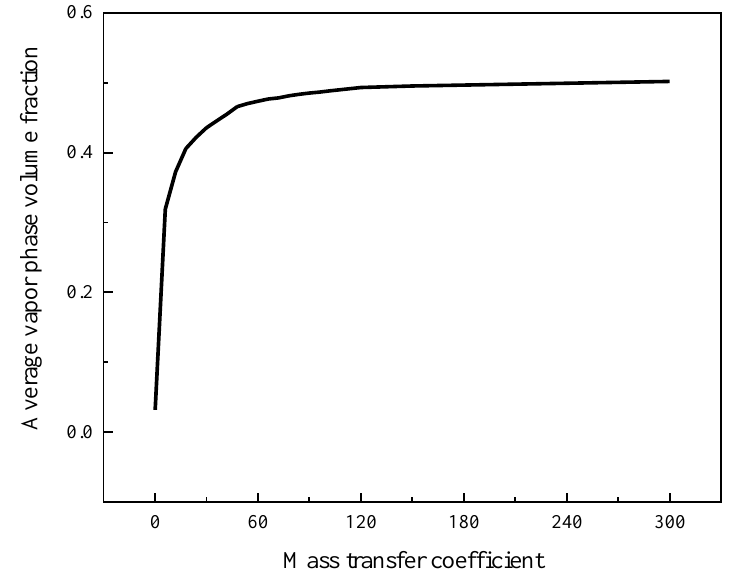
Figure 3. Variation of average vapor volume fraction with helix angle under different mass transfer coefficients.